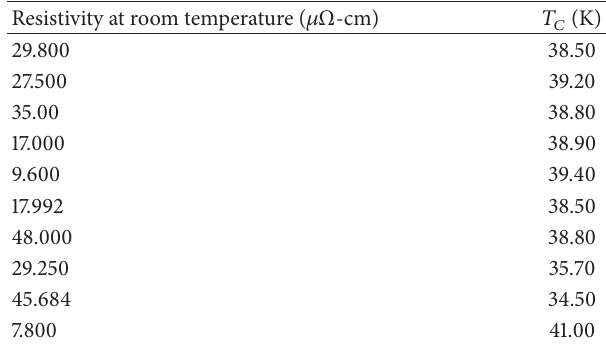
Table 1: The dataset used for modeling